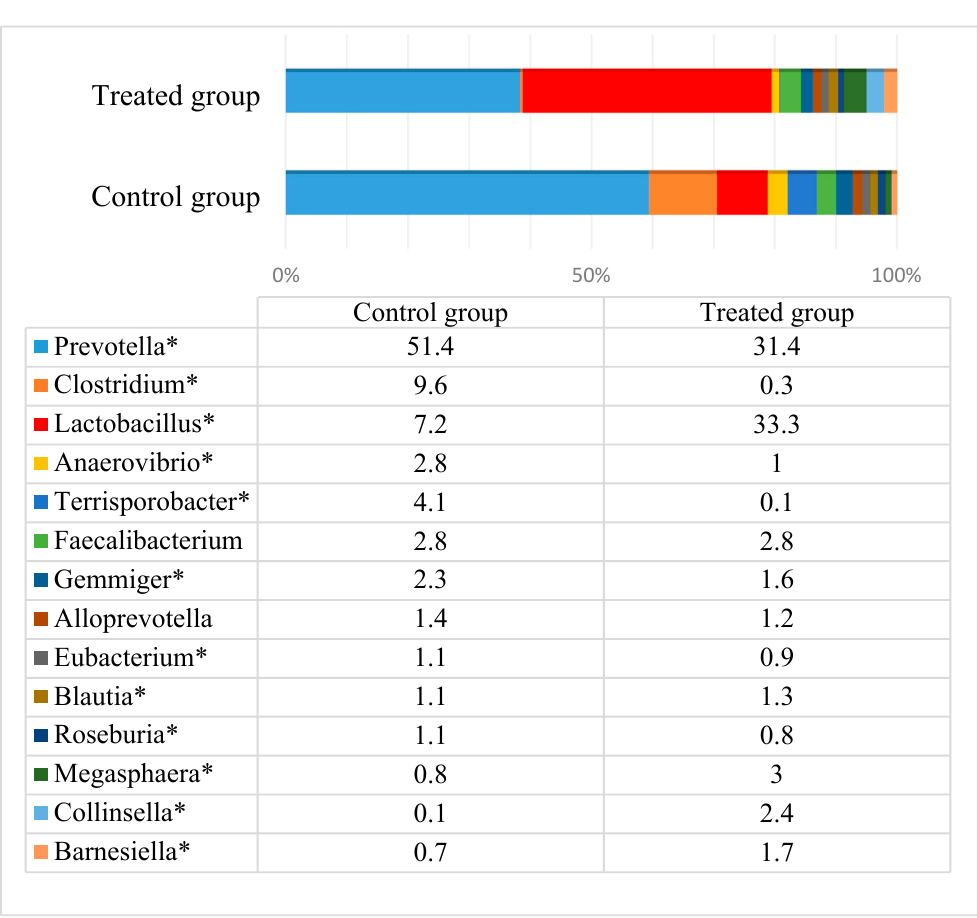
Figure 4. The most prevalent bacterial species (a prevalence of at least 1% from all bacteria in the control or treated group) in the pigs’ feces after the experiment (day 61). * Significant differences in the specific genera between the groups ( p ≤ 0.05).